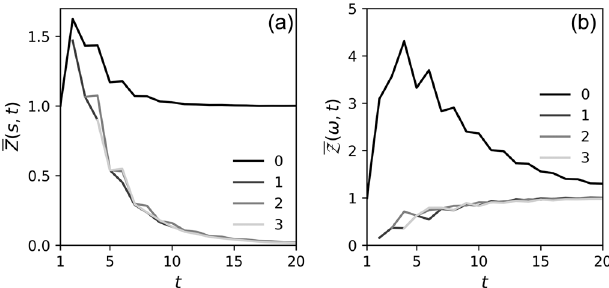
¯ Z ð ω ; t Þ ¯ Z ð s; t Þ ¯ Z ð s; t Þ FIG. 14. and for q ¼ 2 and L ¼ 8 . (a) , ¯ Z ð 0 ; t Þ with s on the legend. Note that tends to unity, and ¯ Z ð s ≠ 0 ; t Þ decays approximately exponentially as in Fig. 13. ¯ Z ð ω ; t Þ (b) , defined in Eq. (41) as the Fourier components of ¯ Z ð s; t Þ with respect to s . The legend shows n ¼ ω t= 2 π